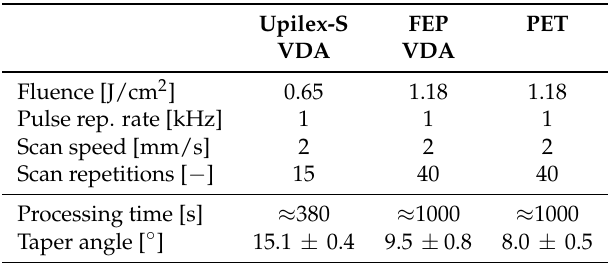
Table 2. Laser parameters used for the processing of the tested tensile samples in different foil materials. The respective total processing time and the resulting taper angle are